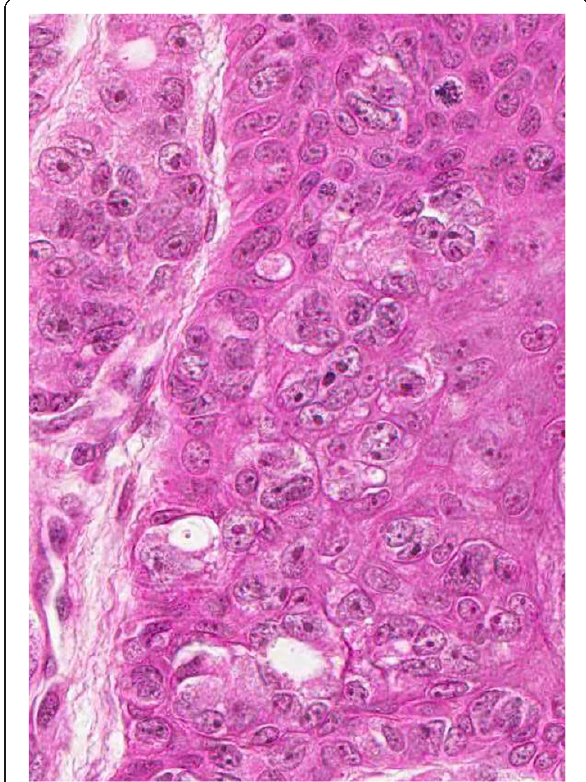
Figure 3 Malignant cells in epidermis: large, clear and clefted nuclei with atypical